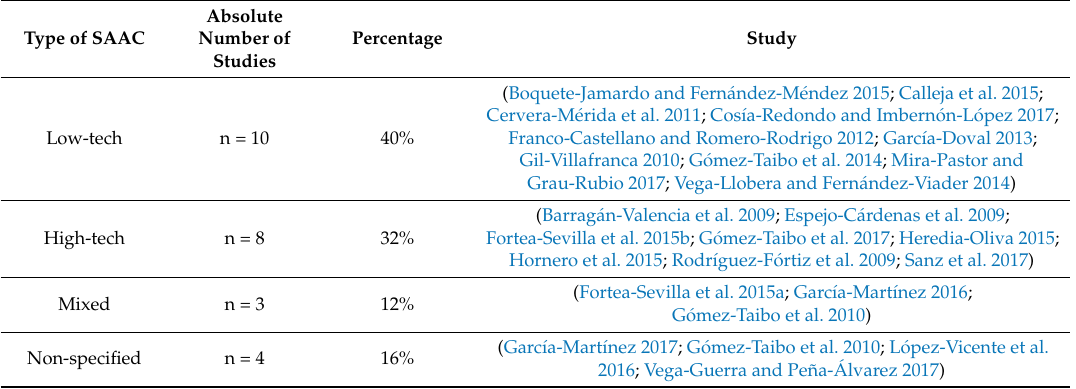
Table 3. Classification of the types of SAACs utilized in the